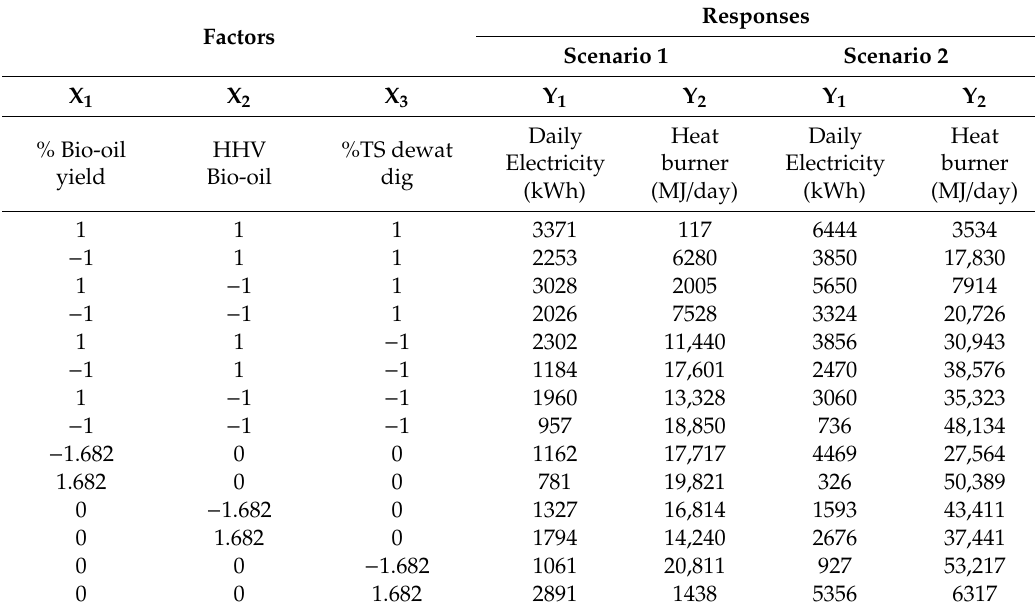
Table 5. Coded matrix for evaluating the energy performance of the integrated digestion-pyrolysis